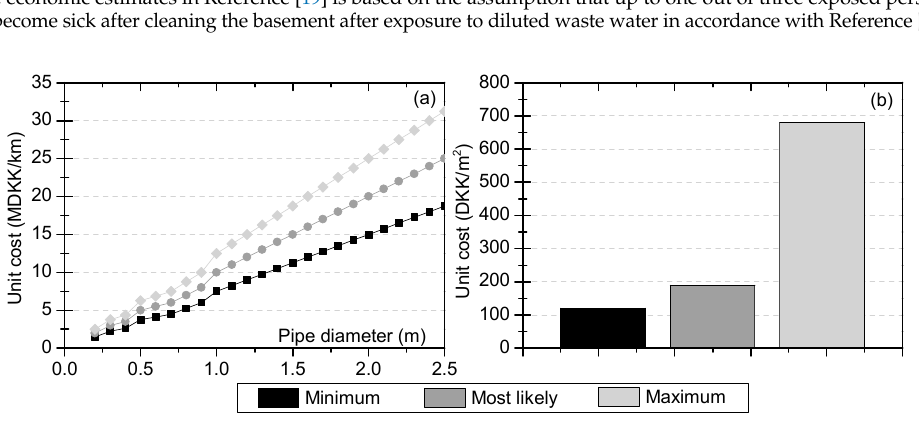
Table 3. Uncertainty ranges of the applied unit costs for each item that can be damaged. Damage Category